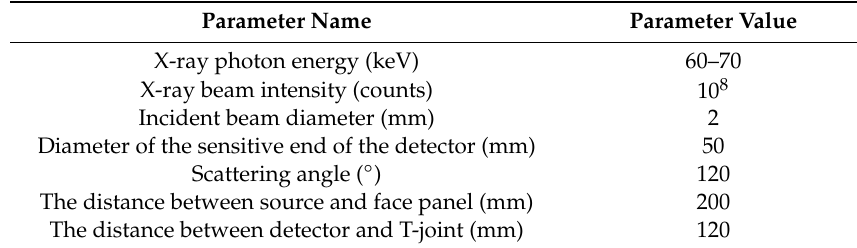
Table 4. The determined primary process parameters of X-ray backscatter detection system.